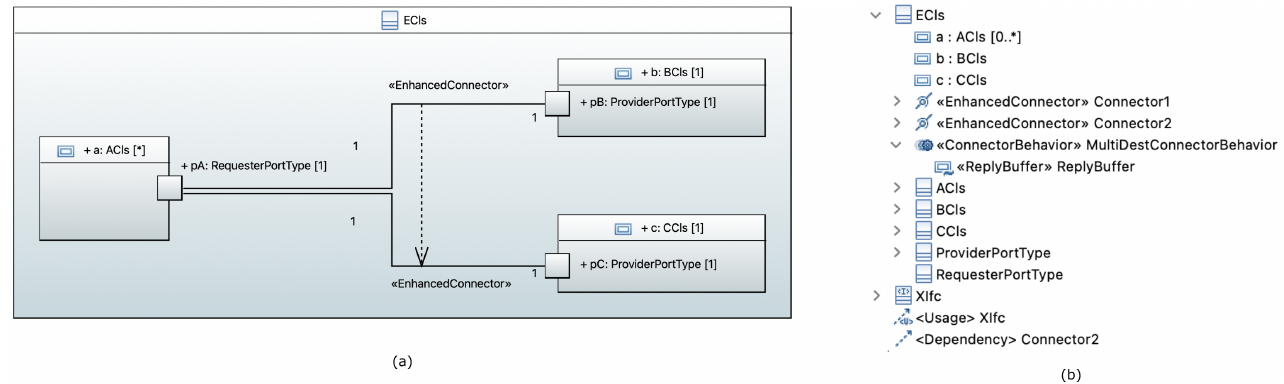
Figure 8. UML diagram and the UML model for the enhanced connector that sends requests to each provider: ( a ) Composite structure diagram showing the requester, providers, and the enhanced connector. ( b ) UML model showing the connector